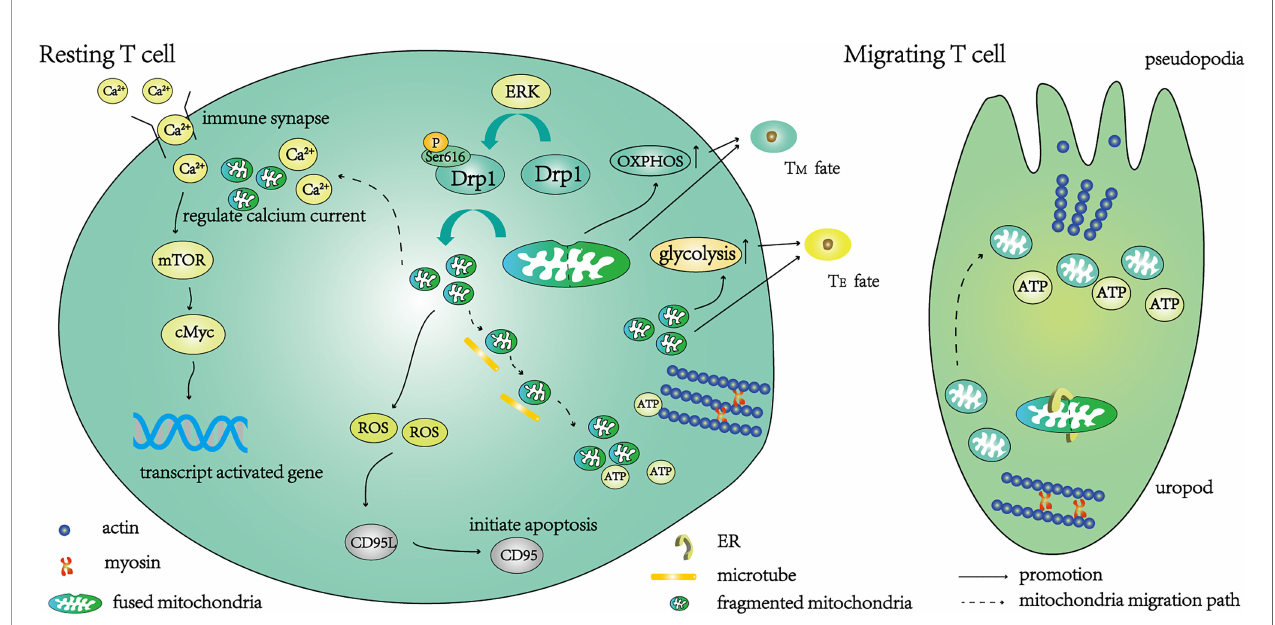
FIGURE 1 | A schematic diagram of the function of T cells regulated by Drp1-mediated mitochondrial fi ssion. Under the action of the ERK pathway, the phosphorylation of Ser616 activates Drp1, and the activated Drp1 mediates mitochondrial fi ssion. After fragmentation, the mitochondria migrate along the microtubule to the uropod, where they provide ATP for T cell movement. The initiation of mitochondrial fi ssion begins with contact between the endoplasmic reticulum (ER) and mitochondria, then resting T cells transition to migrating T cells. Part of the fragmented mitochondria migrates to the immune synapse, where calcium ions are absorbed to regulate calcium currents. Under a suitable calcium current, mTOR and cMyc are further activated to enhance the transcription of activation-related genes. The main metabolic pathway of these T cells is glycolysis, and the T cells differentiate into effector T cells (T E ). Fragmented mitochondria also produce ROS, activate CD95L transcription, further activate CD95 and mediate T cell apoptosis. T cells are converted to a memory-like phenotype (T M ) when knockdown of Drp1 inhibits mitochondrial fi ssion and distributes fused mitochondria within T